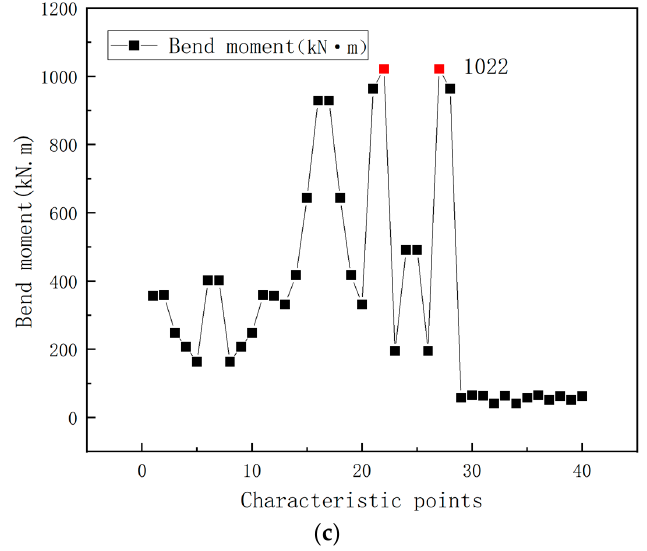
Figure 7. Maximum internal force of the characteristic points of the subway station structure. ( a ) Maximum axial force of the subway station structure. ( b ) Maximum shear force of the subway station structure. ( c ) Maximum bending moment of the subway station structure.